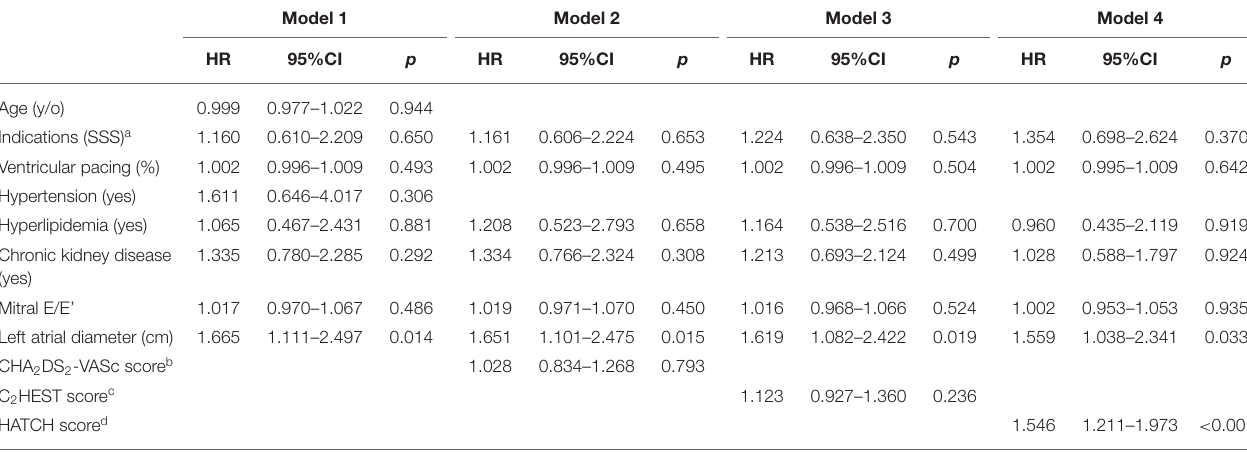
TABLE 5 | Multivariate logistic regression analysis for independent factors of subsequent atrial high rate episodes ≥ 3min.